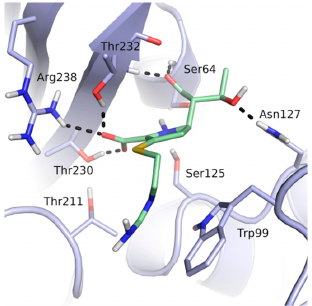
Figure 1. The binding site of GES-5 (PDB code 4H8R) with ligand imipenem (green). Hydrogen bonds are indicated as black dots. The carboxylate group of imipenem is oriented in the oxyanion hole formed by Ser125, Thr211, Thr230 and Thr232.